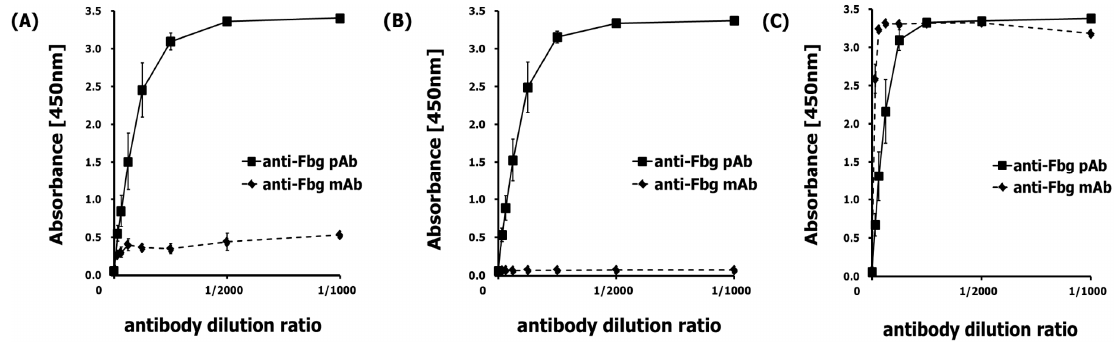
Figure 1. Each anti-Fbg, pAb and mAb, was tested using the indirect ELISA system. ( A ) At an Fbg- coated plate, the pAb had good affinity while the mAb had poor affinity. ( B ) At an Fbg fragment E- coated plate, the pAb had good affinity while the mAb had no affinity. ( C ) At an Fbg fragment D- coated plate, both the pAb and the mAb had good